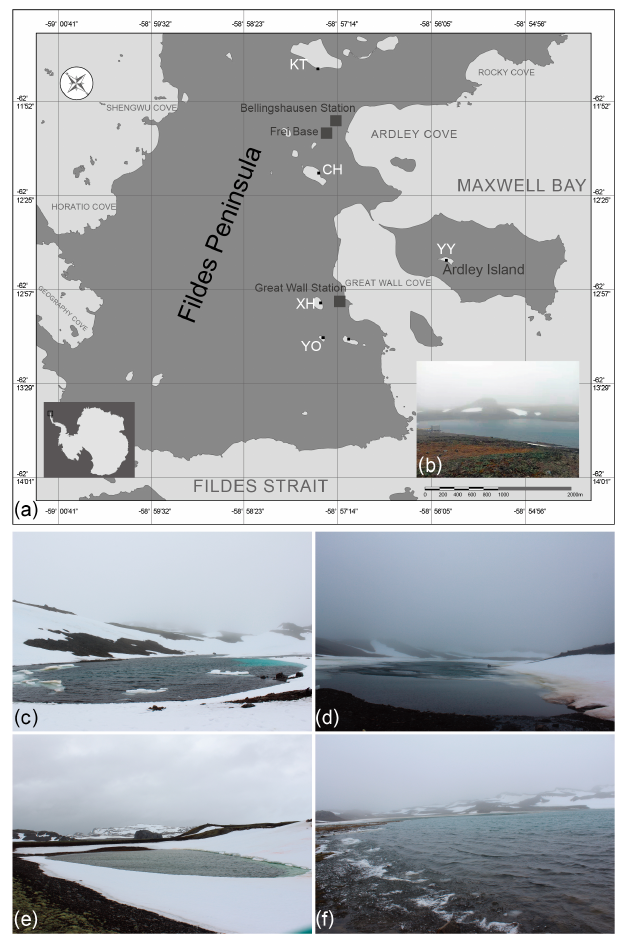
Figure 1. (a) Location of the five studied lakes on the Fildes Peninsula, King George Island, Antarctica, (b) Lake Xi Hu (XH), (c) Lake Yan Ou (YO), (d) Lake Chang Hu (CH), (e) Lake Yue Ya (YY), and (f) Lake Kitec